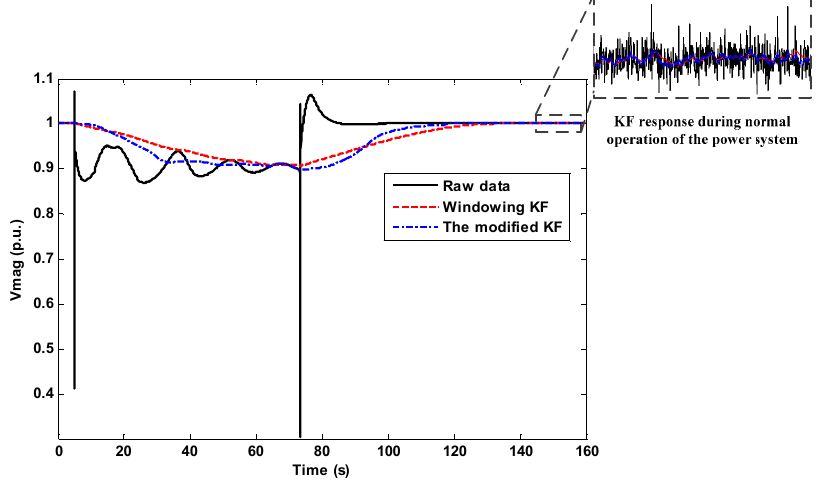
Figure 7. Comparison of two proposed KF methods (for PMU’s voltage magnitude signal). Energies 2016 , 9 , 315